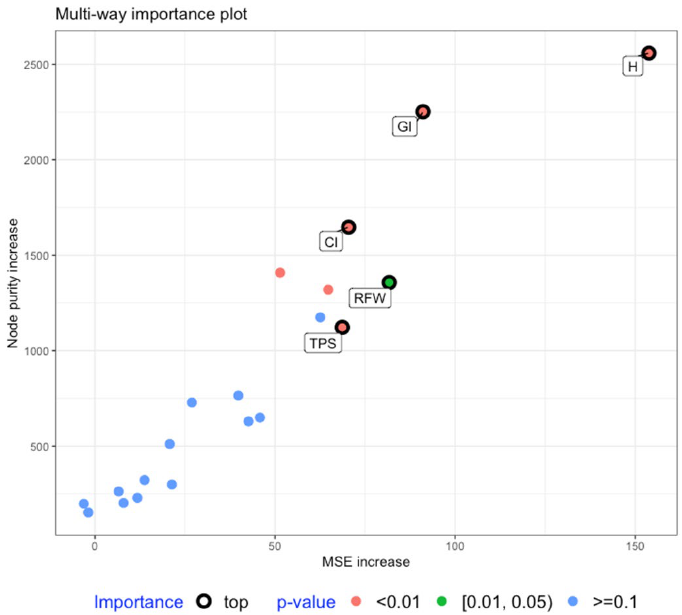
Figure 1. Multiway importance plot of all the parameters studied using the random forest (RF) analysis. MSE: mean squared error; Cl: chloride; GI: germination; H: shoot height; RFW: root fresh weight; TPS: total pore space. The red points correspond to WSK (water-soluble K) and ADW (aerial dry weight). The marked circles correspond to the most relevant variables related to the proportion of coir fiber in the